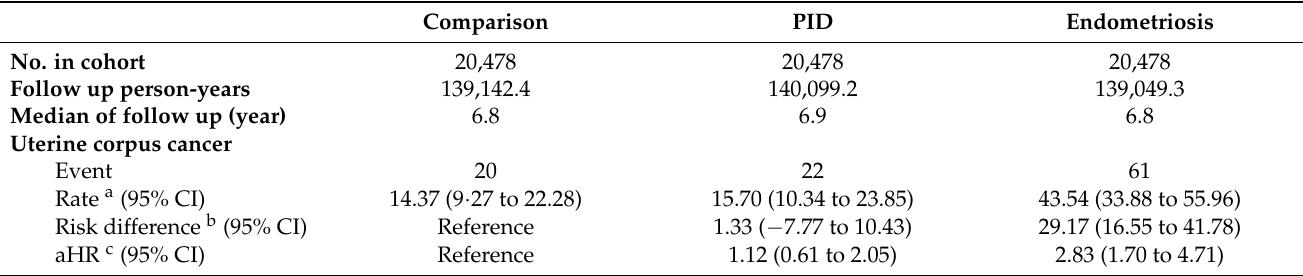
Table 3. Incidence rate of uterine corpus cancer among study groups after propensity score